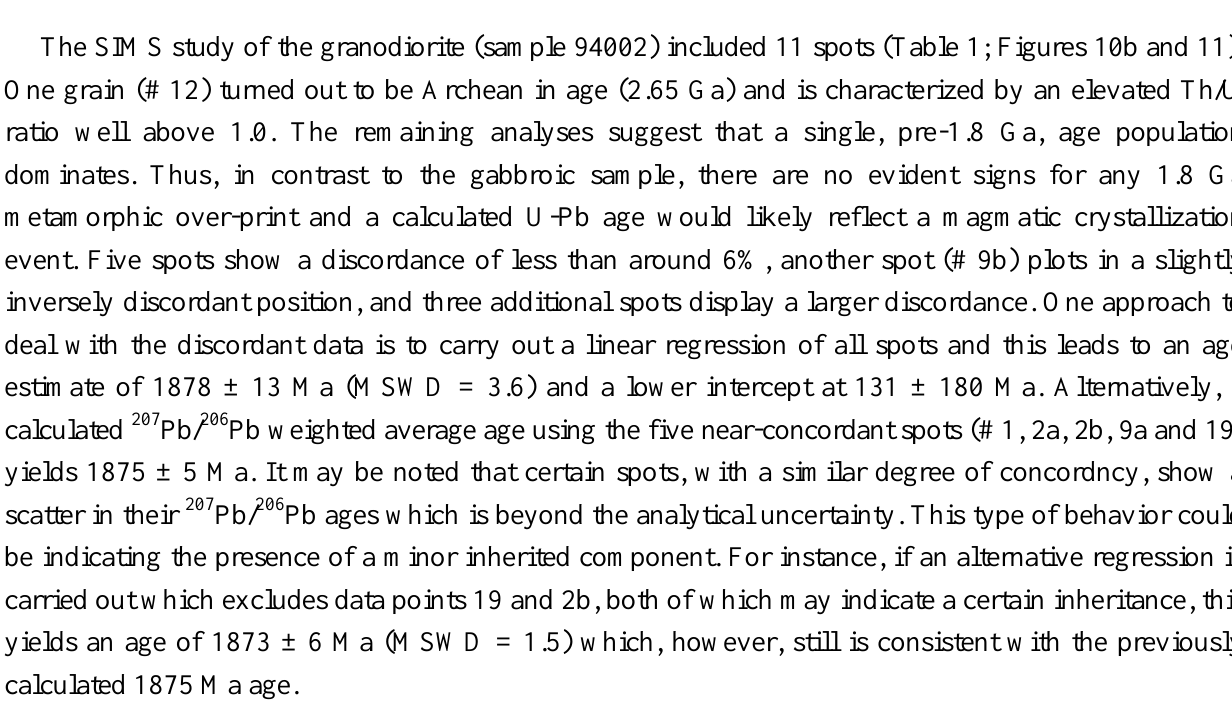
Figure 11. U-Pb concordia diagrams with SIMS zircon data for the granodiorite; data with a pronounced discordance and indicating Archean ages are